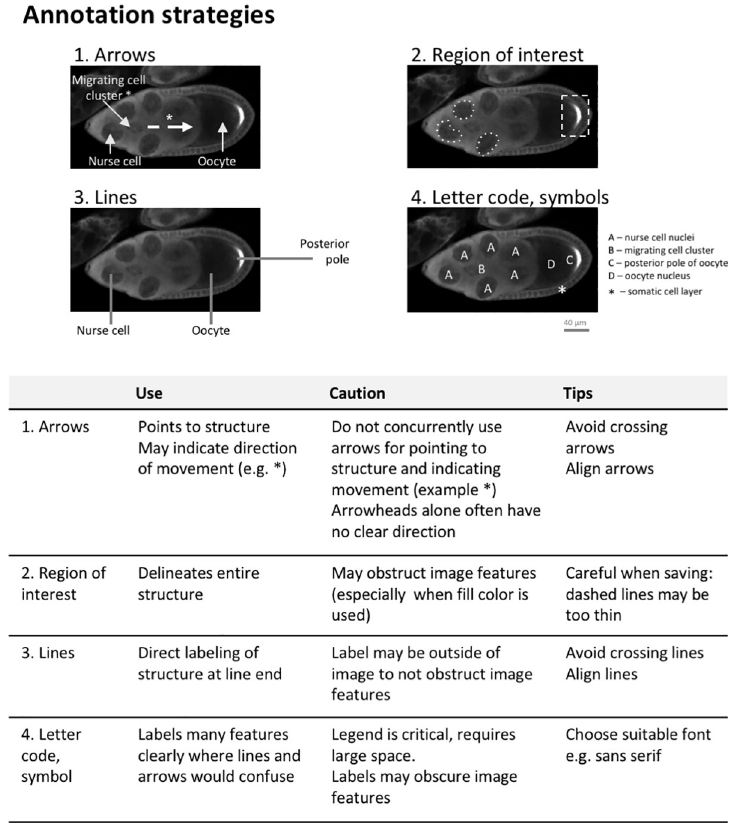
Fig 10. Using arrows, regions of interest, lines, and letter codes to annotate structures in images. Text descriptions alone are often insufficient to clearly point to a structure or region in an image. Arrows and arrowheads, lines, letters, and dashed enclosures can help if overlaid on the respective part of the image. Microscope images show D . melanogaster egg chambers [18], with the different labeling techniques in use. The table provides an overview of their applicability and common pitfalls. All images have the same scale.